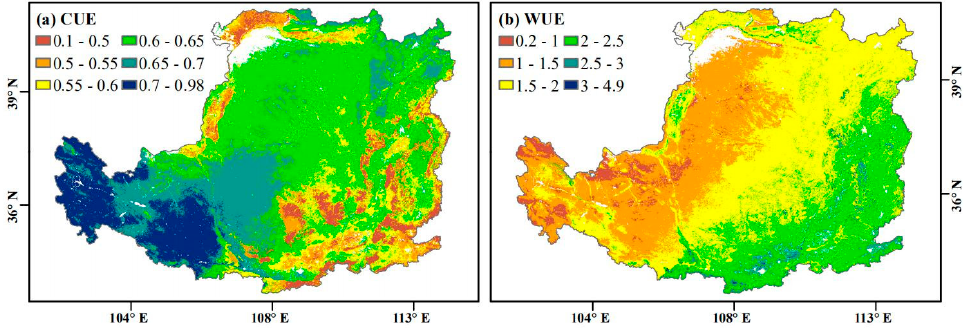
Figure 4. Characteristics of the spatial distribution of CUE ( a ) and WUE ( b ) in the Loess Plateau.